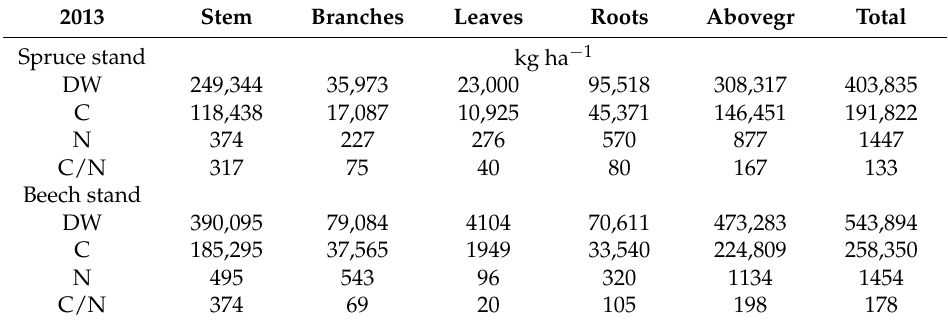
Table 2. Stocks (kg · ha − 1 ) of biomass (dry weight), carbon, nitrogen and the mass ratio of C:N in spruce and beech